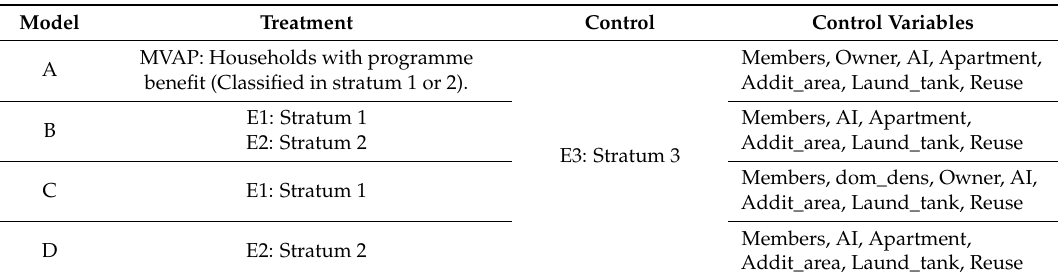
Table 6. Results of the difference-in-difference regression model.